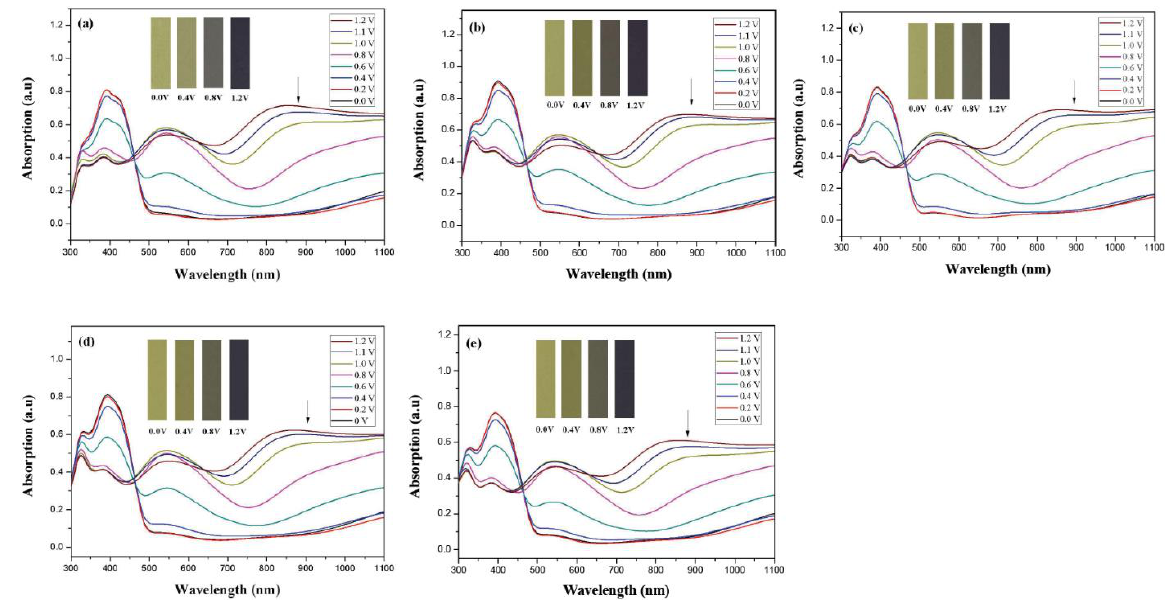
Figure 5. UV-Visible spectra of ( a ) PDTC, ( b ) P(DTC- co -BTP), ( c ) P(DTC- co -BTP2), ( d ) P(DTC- co -TF), and ( e ) P(DTC- co -TF2) in 0.2 M LiClO 4 /ACN solution.